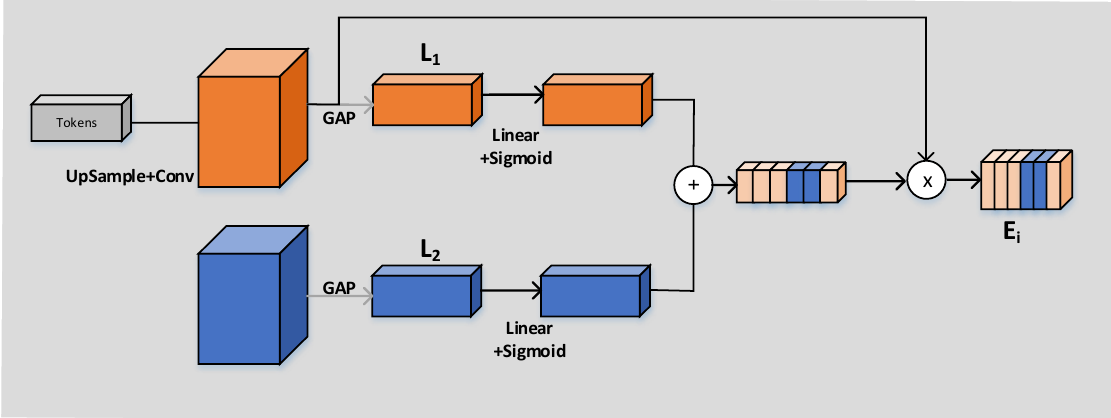
Figure 6. Channel cross-attention module.